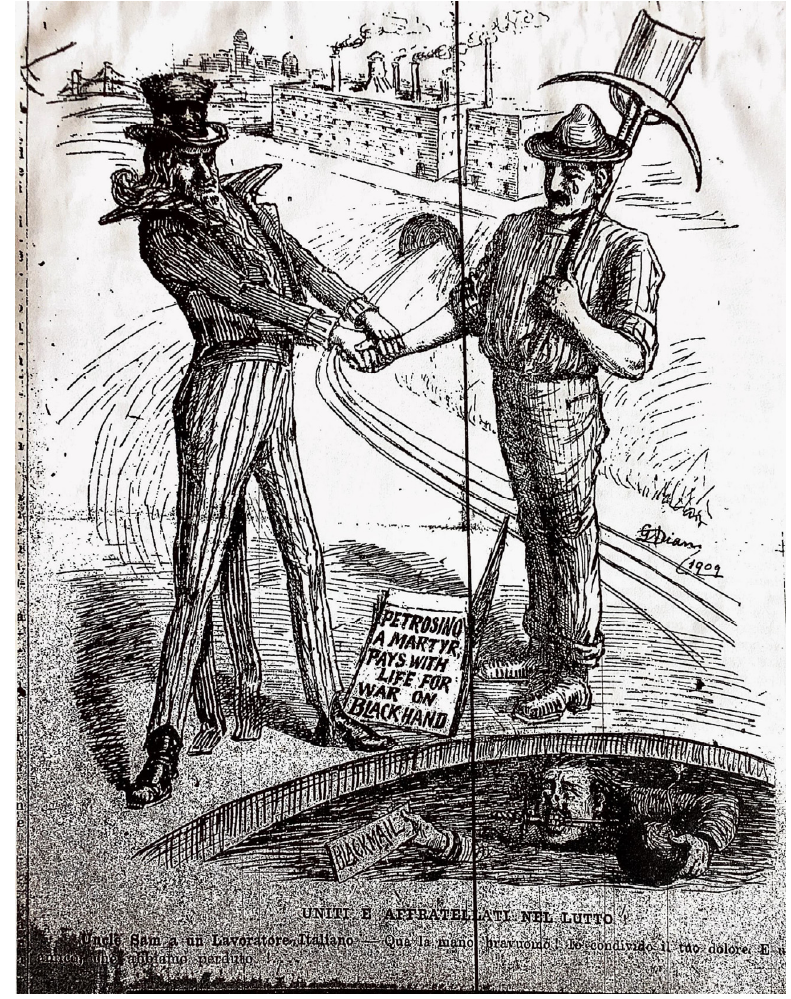
Figure 3. La Follia di New York , 21 March 1909, p.